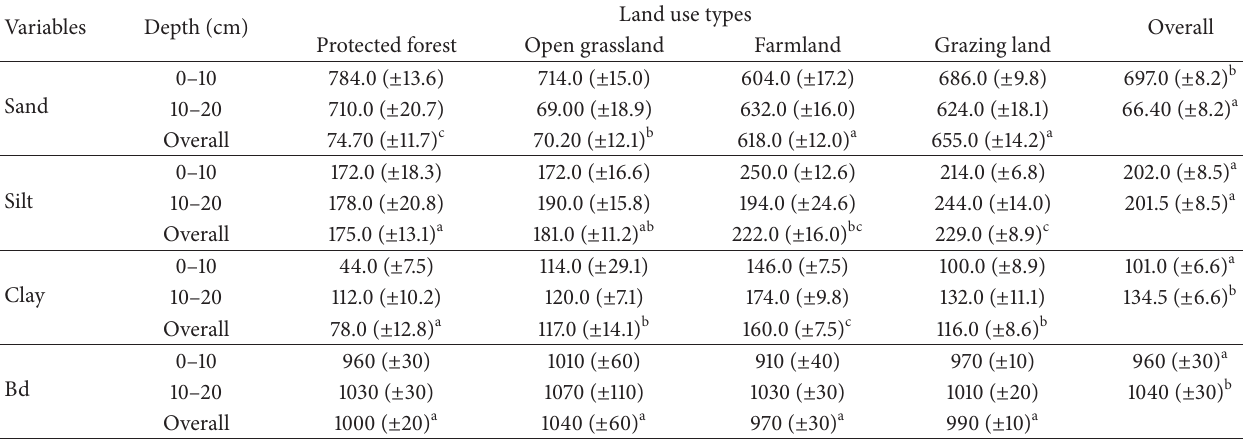
Table 1: Soil textural fractions (gKg − 1 ), and soil bulk density (BD, Kgm − 3 ) in relation to land use (Mean ± S.E.) and soil depths (cm).